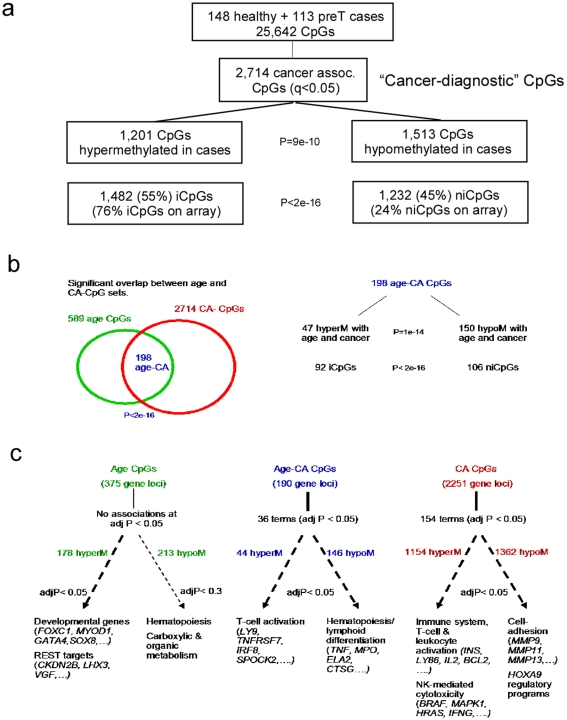
Cancer and age CpGs, and GSEA.
a) Distribution of 2,714 CA-CpGs (FDR<0.05) in terms of hyper-and-hypomethylation (Binomial test P-value given), as well in relation to CpG localisation (Fisher's exact test). b) Overlap of age-CpGs with CA-CpGs (Fisher-test P-value of overlap given) and distribution of the 198 common age and CA-CpGs in terms of hypermethylated and hypomethylated patterns and iCpGs/niCpGs (Binomial and Fisher-test P-values are given, respectively). Out of the 198 CpGs, 47 exbited hypermethylation with age and cancer, 150 hypomethylation with age and cancer, 1 hyperM with age and hypoM with cancer and 0 showed hypoM with age and hypeM in cancer. c) Gene Set Enrichment Analysis for the common age CA-CpGs, age-specific CpGs (i.e age CpGs minus CA-CpGs) and CA-specific CpGs (i.e CA-CpGs minus age-CpGs) stratified according to hyper/hypometylation. Benjamini-Hochberg adjusted P-values are given. Most significantly enriched biological terms are given.